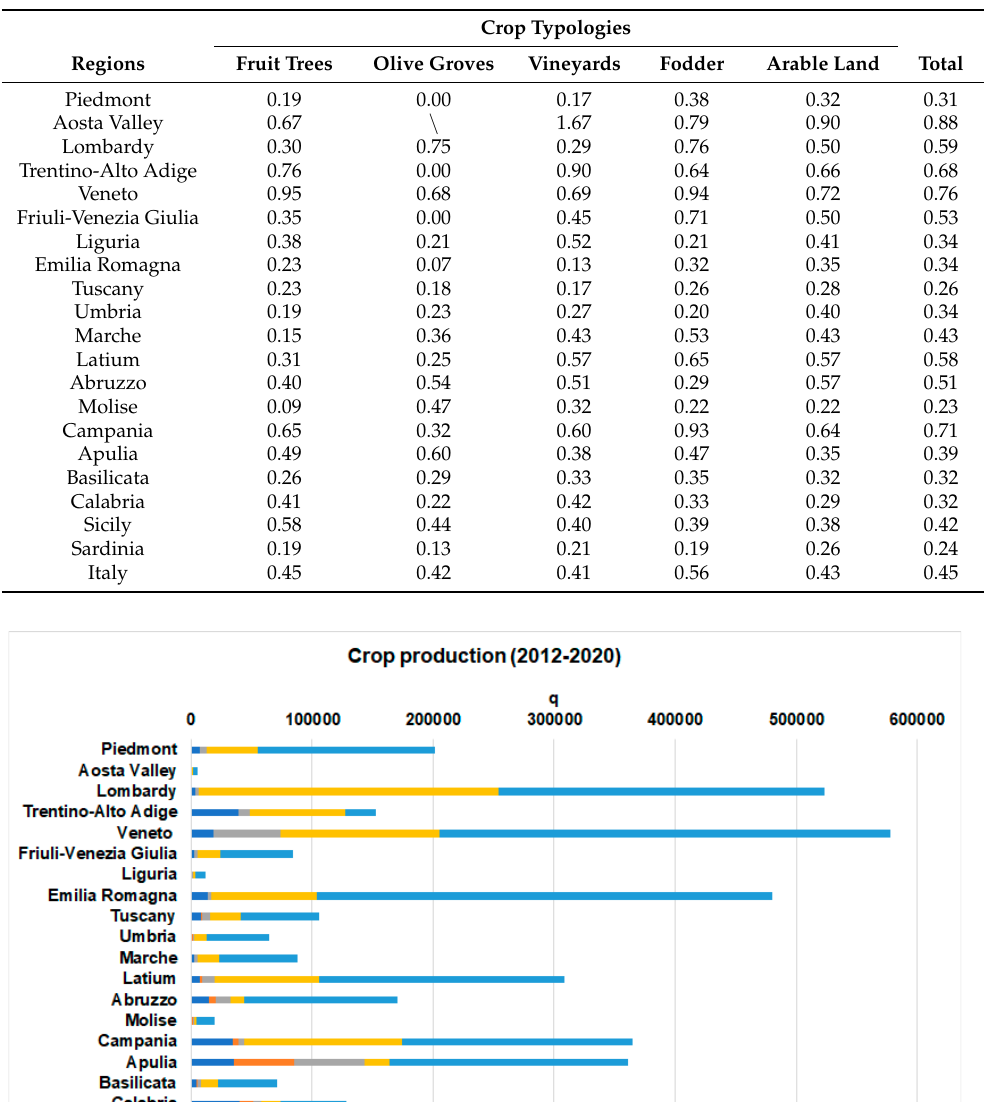
Table 4. Percentage loss of crop production due to land consumption for five agricultural classes in the period 2012–2020 at the regional level.